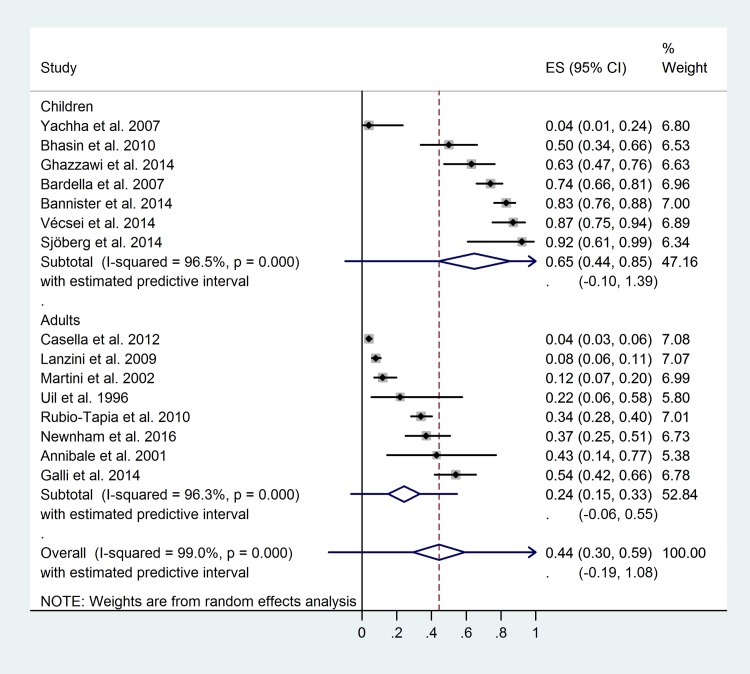
Forest plot: Complete mucosal recovery ratios of children-to-adults comparison.